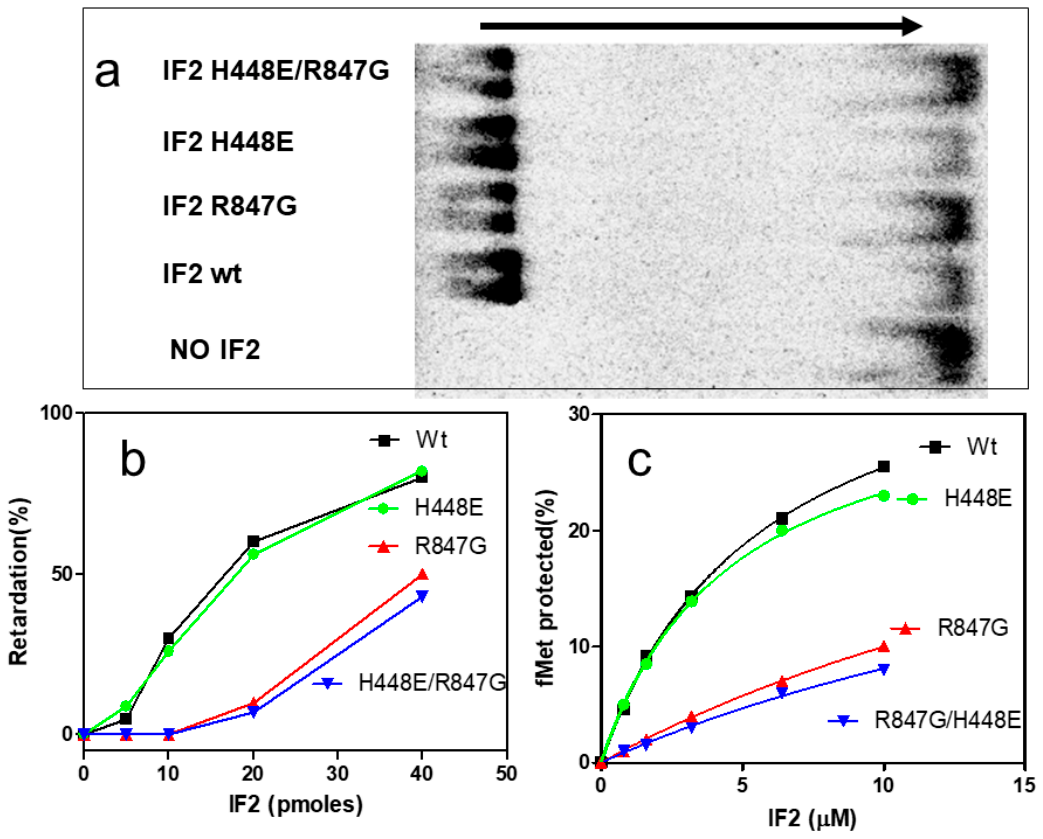
Figure 6. Affinity of IF2 wt and IF2 mutants for fMet-tRNA. The interaction between fMet-tRNA and IF2 wt or IF2 mutants and was analyzed by gel shift electrophoresis and by fMet-tRNA protection from hydrolysis by RNase A. ( a ) autoradiography of the electrophoretic migration of f[ 35 S]Met-tRNA preincubated with or without IF2 wt or IF2 mutants. The direction of migration is from left to right, as indicated by the arrow. In the absence of IF2, free f[ 35 S]Met-tRNA migrates as a single band to the right, whereas in the presence of IF2 wt and of IF2 H448E, the amount of free f[ 35 S]Met-tRNA is strongly reduced while the bulk of the initiator tRNA is retarded and found in the band at the extreme left. In the presence of IF2 R847G and H448E/R847G, the electrophoretic retardation of fMet-RNA is strongly reduced; ( b ) quantification of the extent of electrophoretic retardation of f[ 35 S]Met-tRNA upon incubation with the increasing amounts of purified IF2 wt (black), IF2 R847G (red), IF2 H448E/R847G (blue), and IF2 H448E (green) indicated in the abscissa; ( c ) extent of fMet-RNA protected from RNase hydrolysis upon incubation with the indicated amounts of IF2 wt (black), IF2 R847G (red), IF2 H448E/R847G (blue), and IF2 H448E. Further details can be found in Materials and Methods.